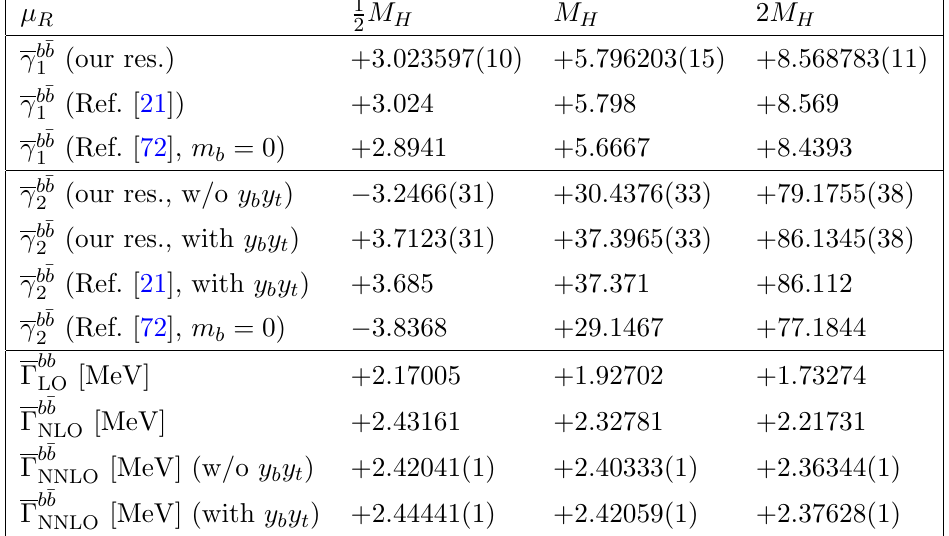
and (cid:13) b (cid:22) b . For comparison we include correspond- 1 2